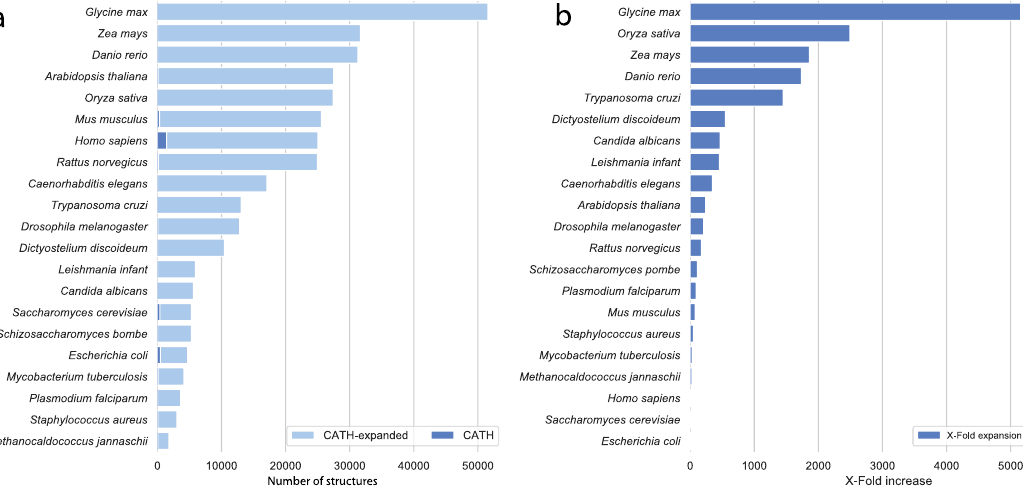
Fig. 4 Structural coverage expansion. a Expansion in structural coverage by total number of structural domains and b fold-wise by validated CATH-HMM, Pfam and NewFams domains models for the 21 organisms in the AlphaFold2 dataset.